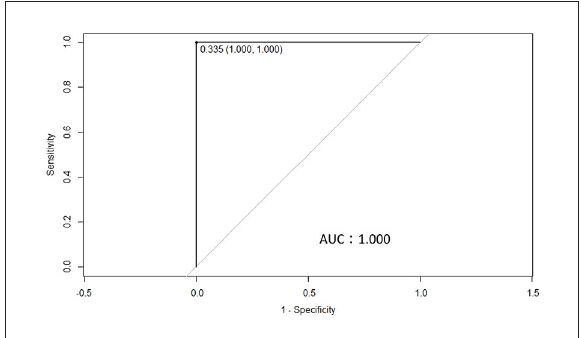
FIGURE1 A receiver operating characteristics (ROC) curve was used to calculate the cut-off point for the S/P ratios of ELISA using whey from 259 dams that were either positive (88 dams) or negative (171 dams) for bovine leukemia virus (BLV), as determined by ELISA in serum. The cut-off point for the S/P ratio was 0.335, while the area under the curve was 1.000.